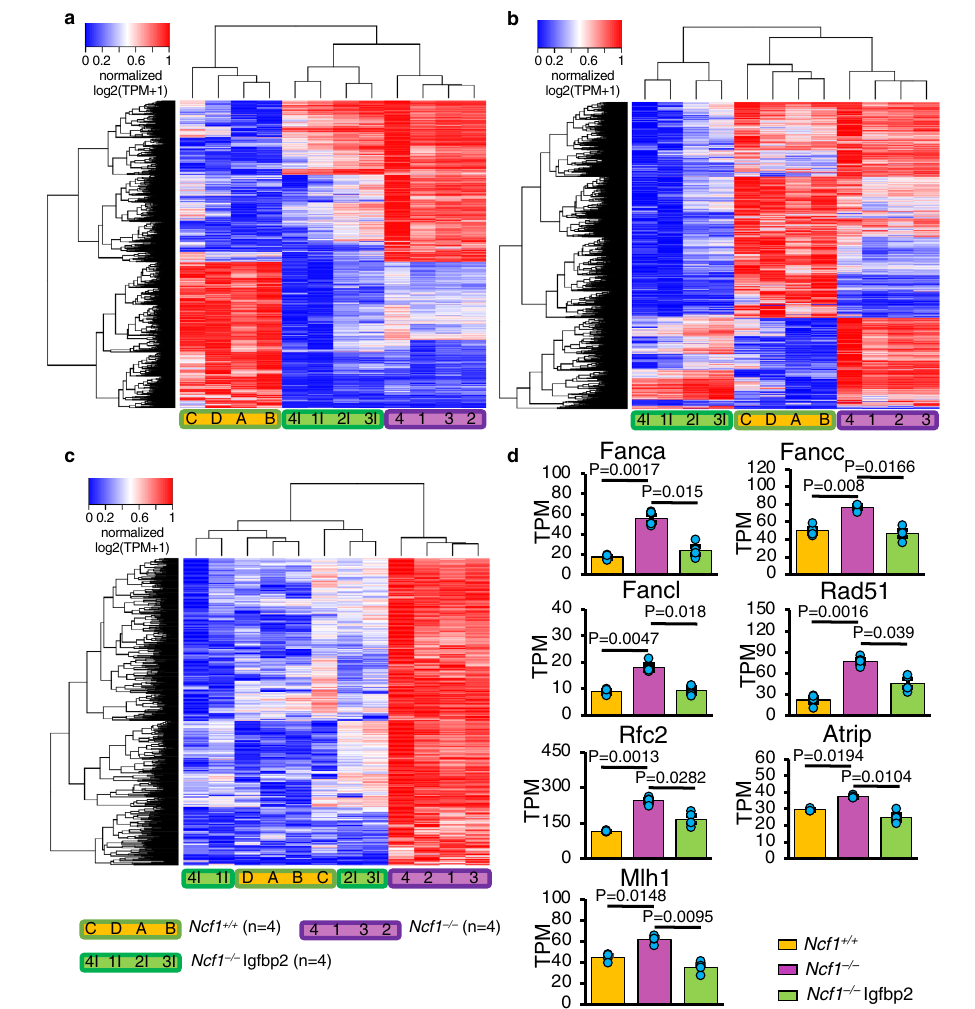
Fig. 3 | Ncf1 represses NSC DNA repair pathways in an Igfbp2-dependent manner. NSCs prepared from4WT(A,B,C,and D)and 4 Ncf1 – / – miceweretreated withvehicle(1,2,3,and4)orIgfbp2(1I,2I,3I,and4I)48hafterplating.Vehicle-and Igfbp2-treated Ncf1 – / – groupsarematchedforNSCpreparationbythenumberwith “ I ” indicating Igfbp2-treatment.Afteradditional48h, totalRNAwascollected